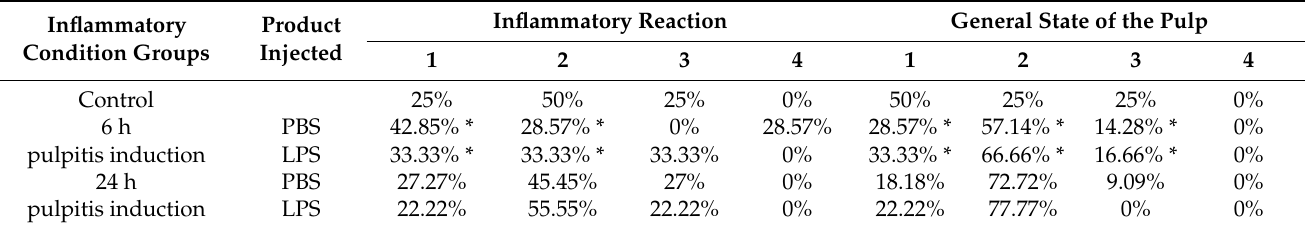
Table 2. Evaluation of inflammation on hematoxylin and eosin-stained histological sections on D15 using the scoring table (Table 1). A t -test was performed to detect any significant differences between the groups using GraphPad Prism version 6 (GraphPad Software, CA, USA) * p < 0.05. Results for 6-h PBS and LPS treatment were significantly different from those for 24-h PBS and LPS treatment for criteria 1 and 2 of inflammatory reaction and criteria 1, 2 and 3 for the general state of